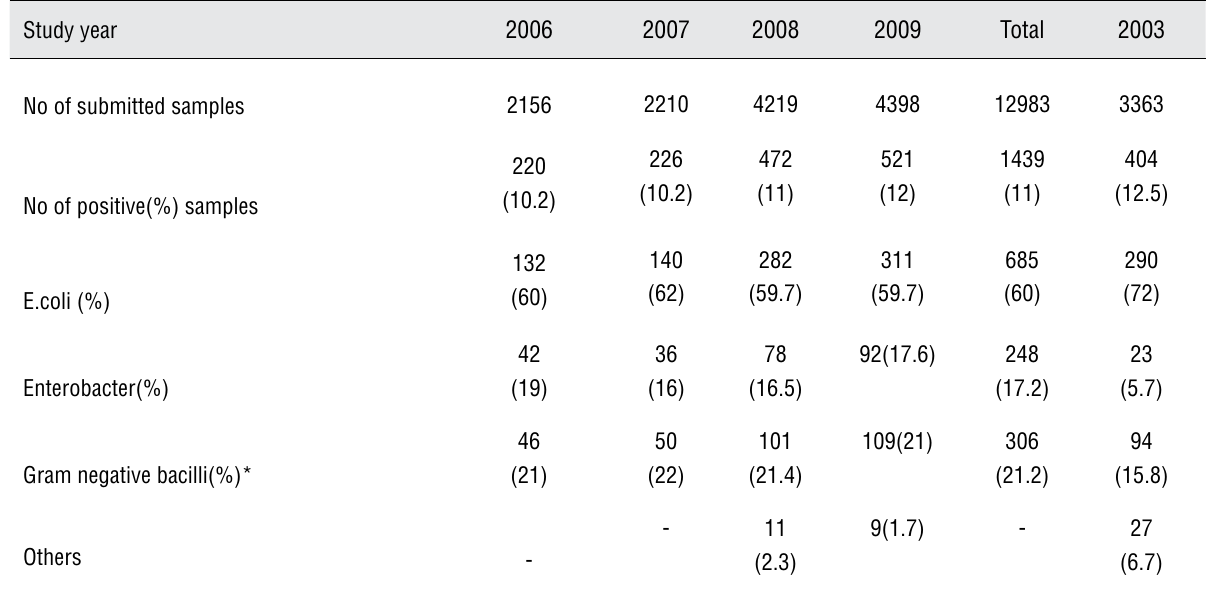
Table 1 - Relative distribution of submitted urine samples and isolation rates of bacterial species causing urinary tract infec- tions based on the year of study,